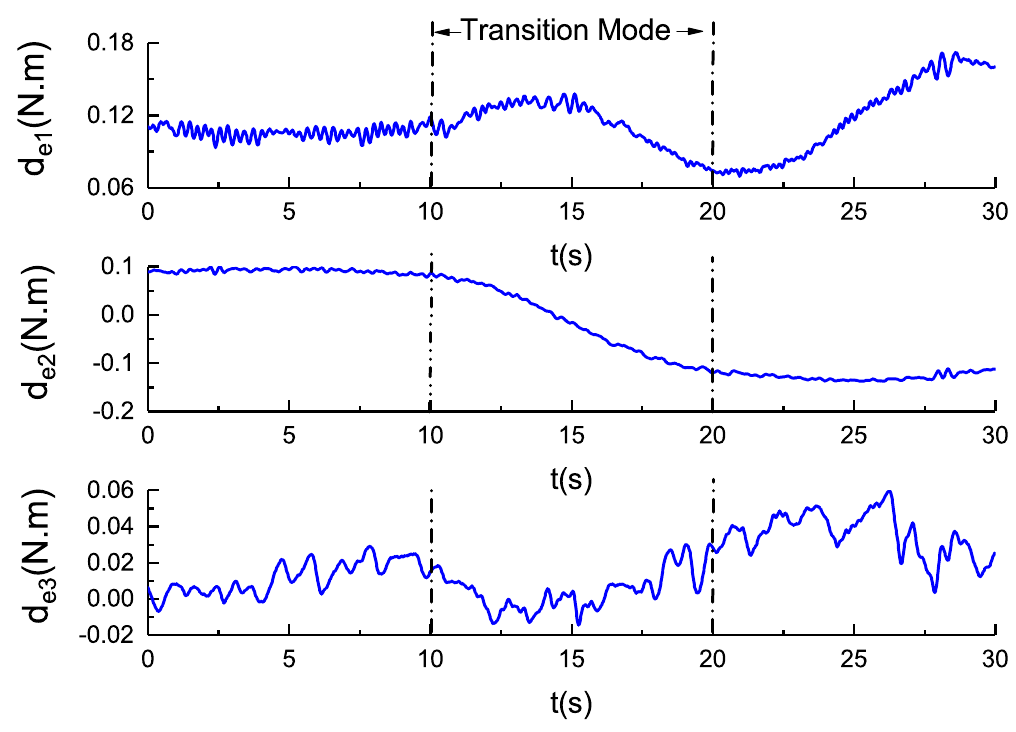
Figure 13. Disturbance estimation with the LESO on in transition